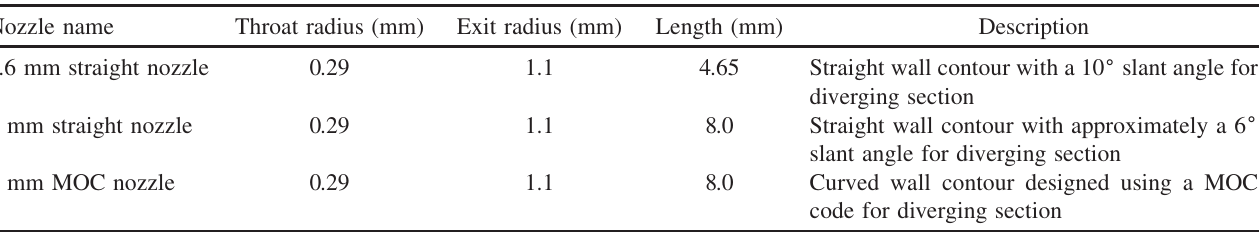
TABLE I. Geometric specifications for the various nozzle